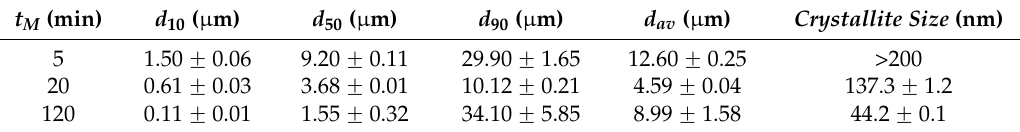
Table 1. Particle size characteristics, as determined by laser scattering analysis, and crystallite size, obtained using the Rietveld analytical procedure, of differently ball-milled SHSed